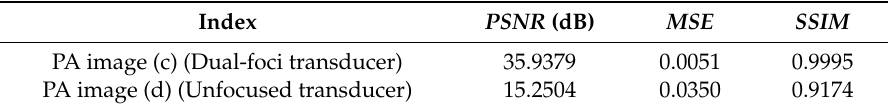
Table 2. Quality evaluation of reconstructed